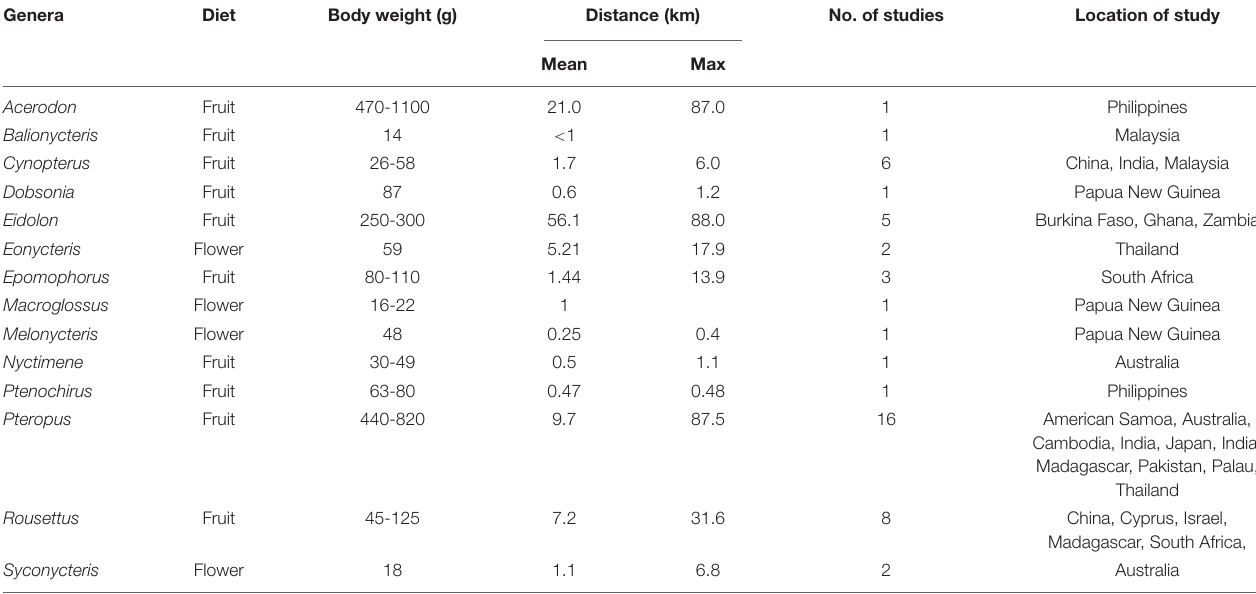
TABLE 2 | Summary of movement studies on pteropodid genera